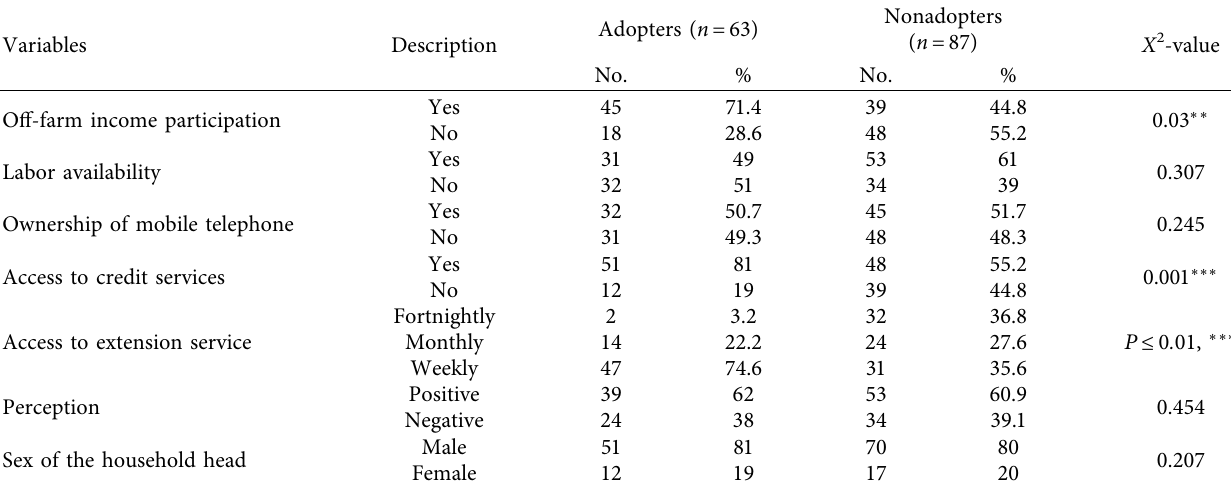
Table 7: Statistical summary of sampled adopters and nonadopters on dichotomous variables.